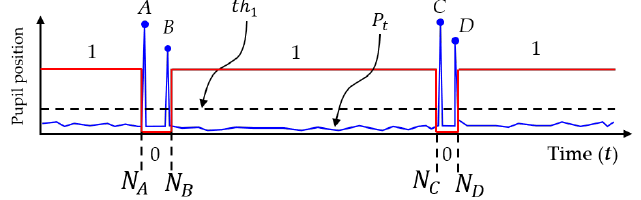
Figure 18. Thresholding for pupil-disappearance duration